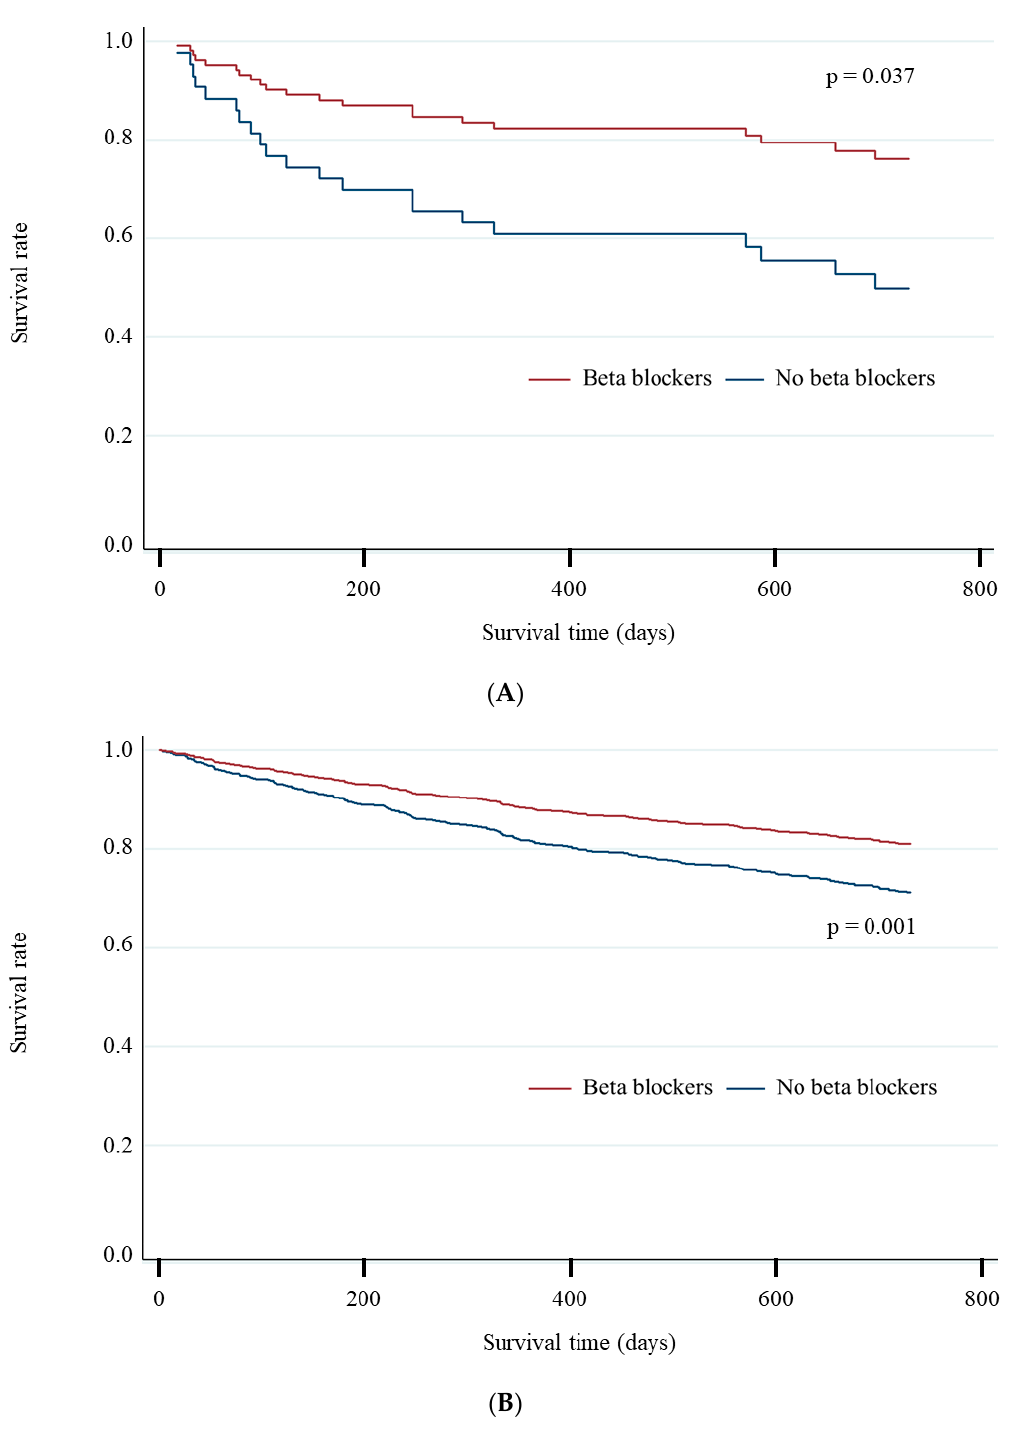
Figure 1. Association of beta-blockers with two-year mortality in patients with and without COPD. ( A ) Association of beta-blockers with two-year all-cause mortality in patients with COPD. ( B ) Association of beta-blockers with two-year all-cause mortality in patients without COPD. Prescription of beta-blockers was associated with a lower all-cause mortality at two years regardless of COPD ( A and B ). Table 4. Cox regression analysis for all-cause mortality at two years.